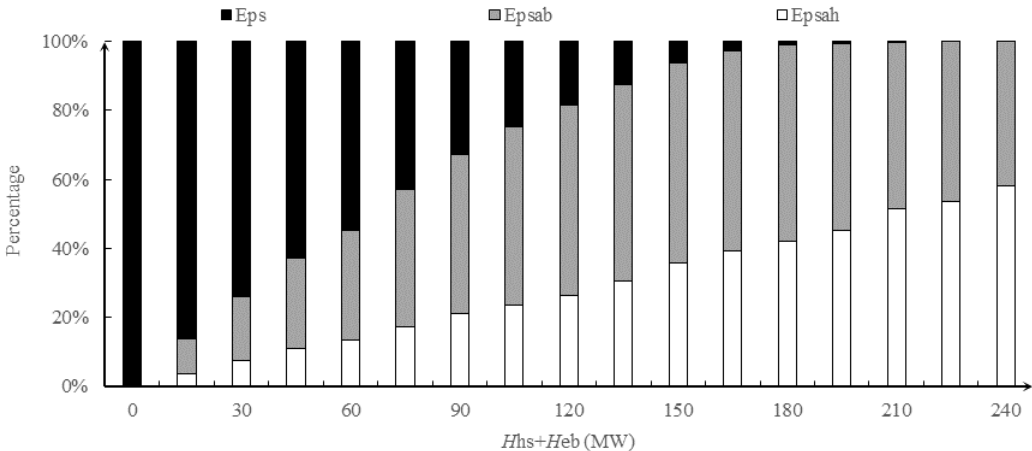
Figure 12. The proportion of the avoidance of wind energy curtailment by different parts of